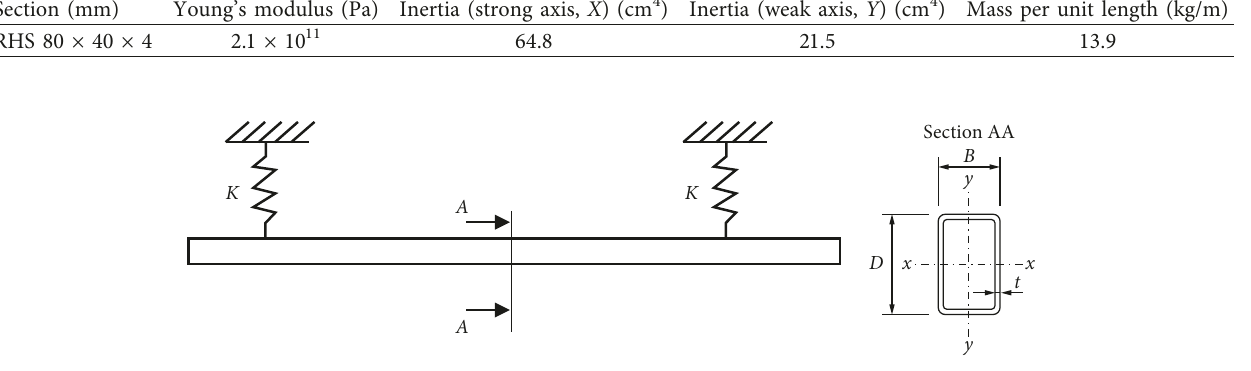
Figure 1: Beam in free-free configuration.